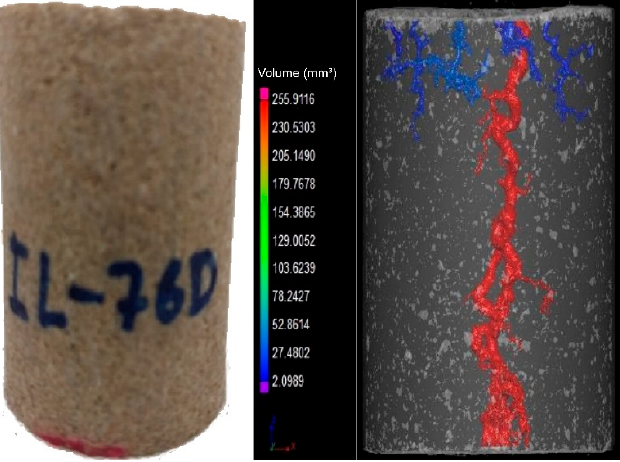
Figure 4. Imaging of wormhole structure using CT scan; ANS2; 0.5 mL/min (IL-76D).